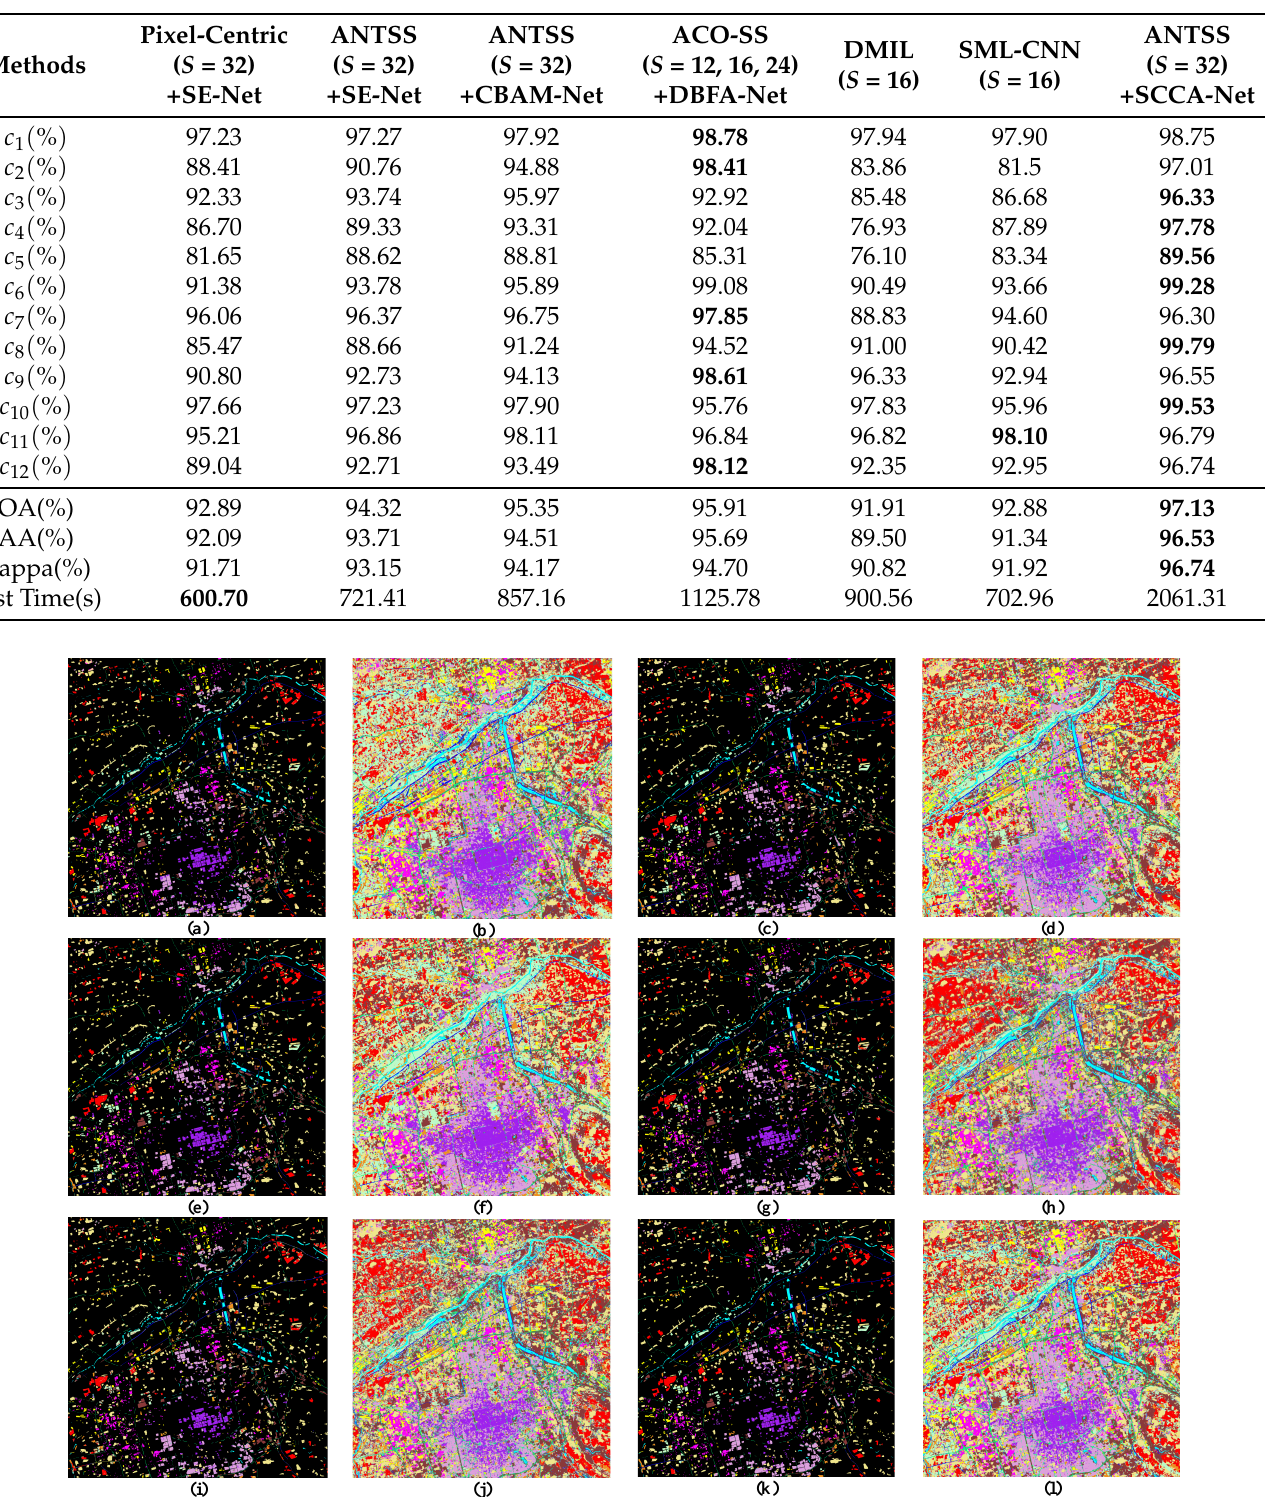
Figure 8. Classification maps of different methods on the Xi’an Level 1A Images (4548 × 4541), each method has two classification maps: one is image with ground truth, while the other is overall image. ( a , b ) Pixel-Centric+SE-Net(Res18). ( c , d ) ANTSS+SE-Net(Res18). ( e , f ) ACO-SS+DBAF-Net. ( g , h ) DMIL. ( i , j ) SML-CNN. ( k , l )